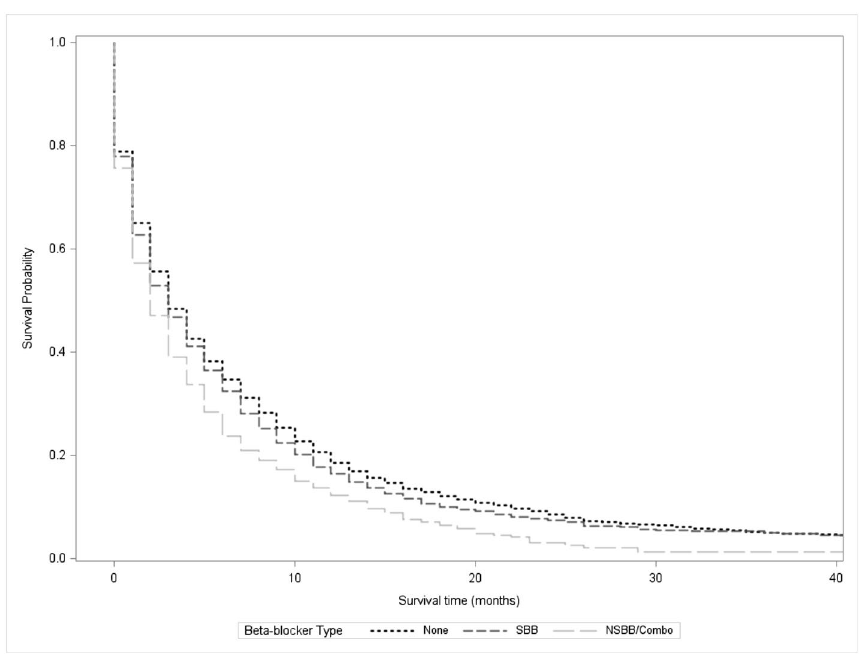
Figure 3. Kaplan–Meier Curve comparing the survival of patients using selective beta-blockers (SBB) and non- selective beta-blockers/combination (NSBB/Combo) to patients not using any beta-blockers (None), p <